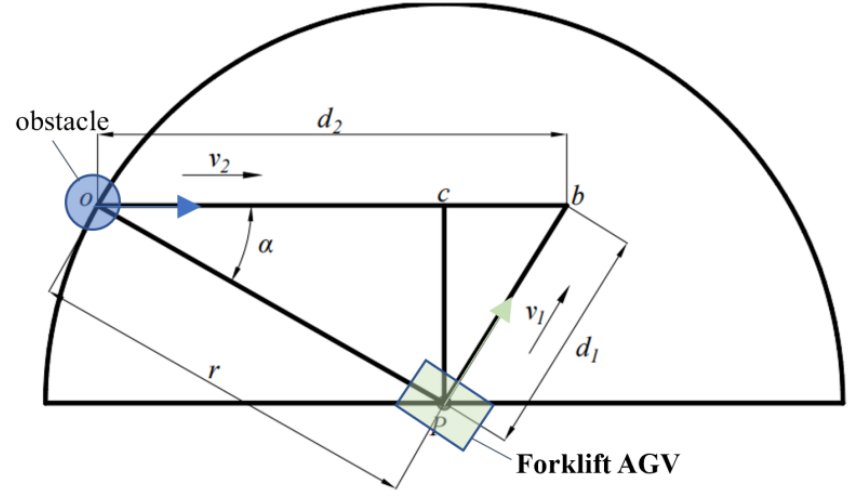
Figure 4 is the model observation diagram. According to the motion relationship between the FAGV and the obstacle, the collision point between the forklift AGV and the dynamic obstacle is calculated.